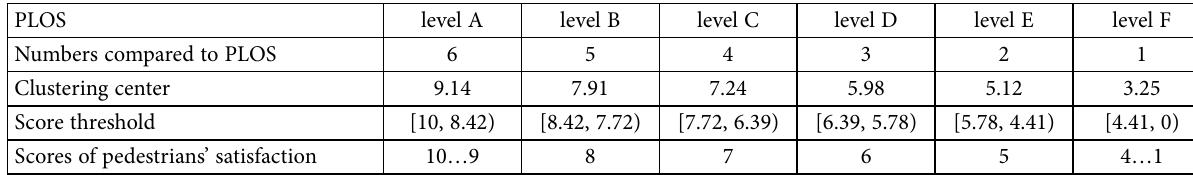
Table 6. Comparison of pedestrians’ satisfaction and